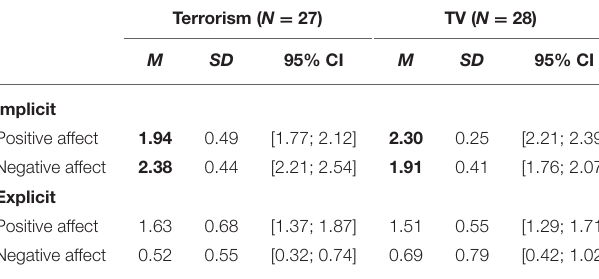
TABLE 1 | Descriptive statistics of dependent variables as a function of experimental